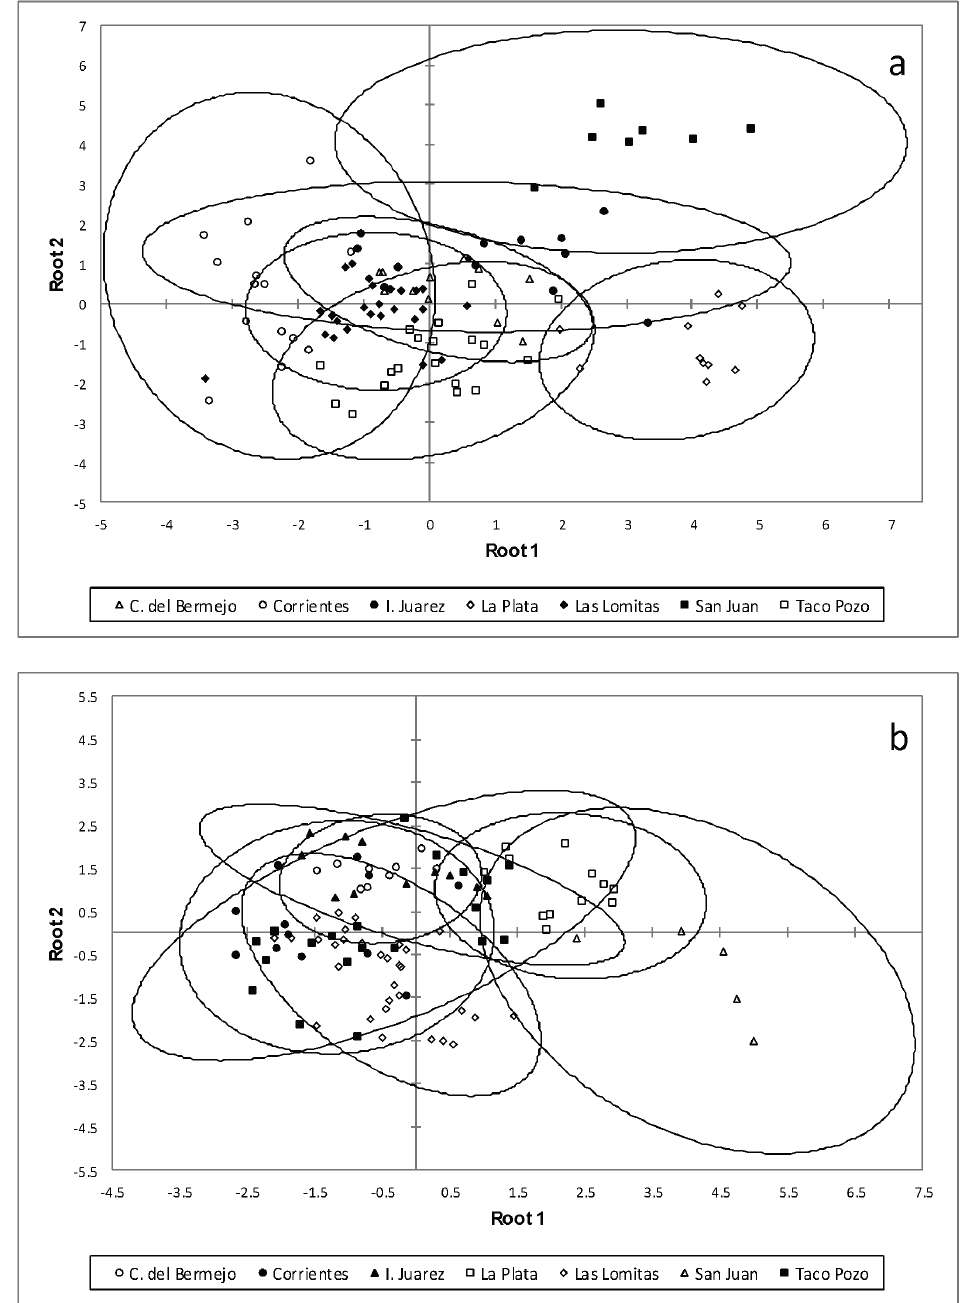
Figure 6 - (a) Plot of the 200 females specimens of the seven localities of Aplectana hylambatis against the first and second discriminant functions resulting from Linear Discriminant Analysis conducted with six variables (see text for explanation). The first two discriminant functions of the model accounted for 91.48% of the total variation among samples, cumulatively. Ellipses represent 95% confidence intervals. (b) Plot of the 201 males specimens of the seven localities of Aplectana hylambatis against the first and second discriminant functions resulting from Linear Discriminant Analysis conducted with five variables (see text for explanation). The first two discriminant functions of the model accounted for 82.94% of the total variation among samples, cumulatively. Ellipses represent 95% confidence